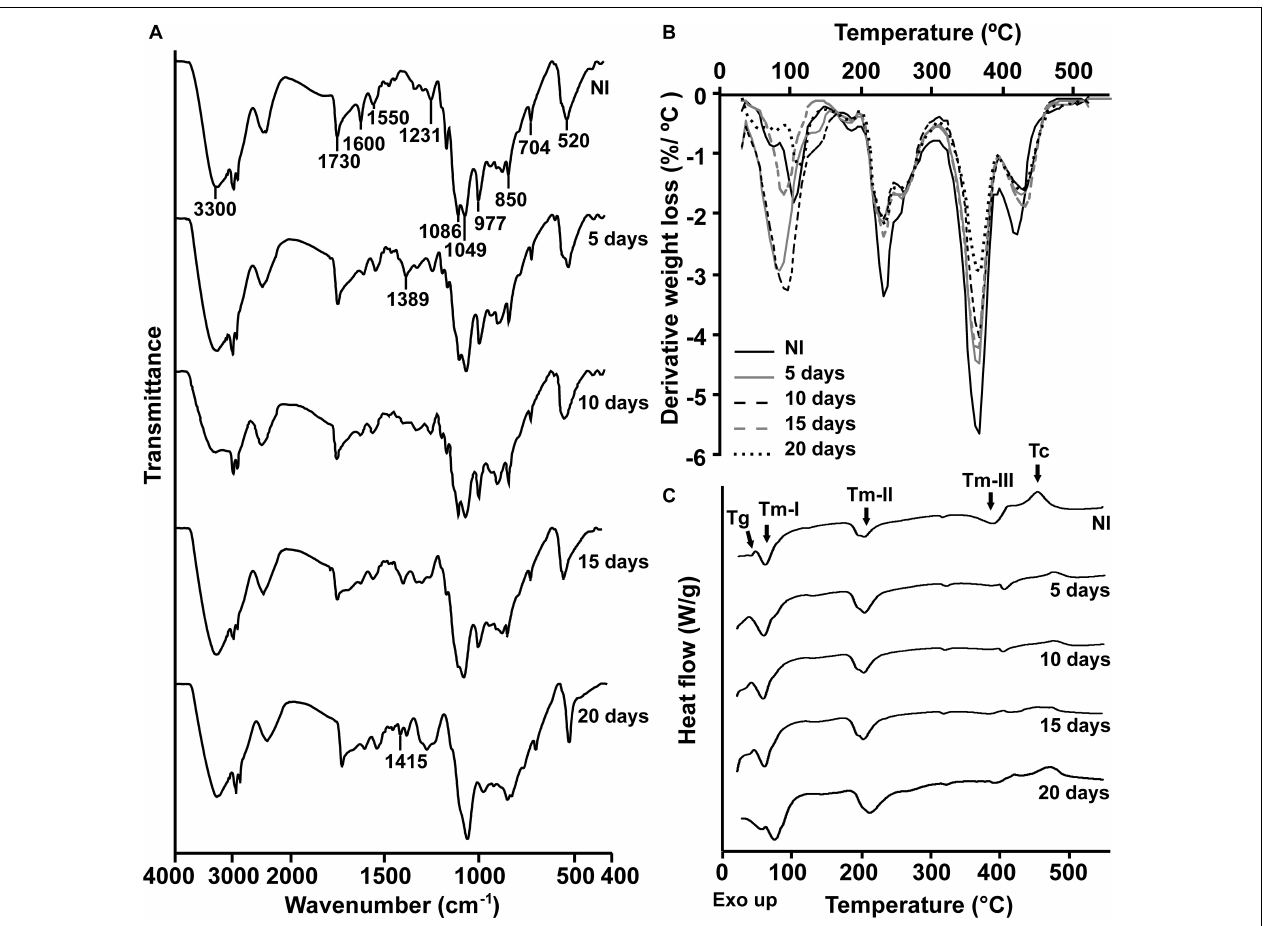
FIGURE 4 | Physical and chemical analyses of the aromatic PE-PU-A copolymer after incubation with the BP8 community. (A) FTIR spectra. (B) DTG analysis. Thermal degradation stages correspond to the following functional groups: (I) Low molecular weight compounds, (II) Urethane, (III) Ester, (IV) Ether. (C) DSC analysis. Glass transition temperature (Tg) represents the relative amount of soft and hard segments; melting temperatures, Tm-I, Tm-II, and Tm-III are associated with hard domains, and crystallization temperature (Tc) represents heat-directed crystallization of copolymer chains. NI, non-inoculated.